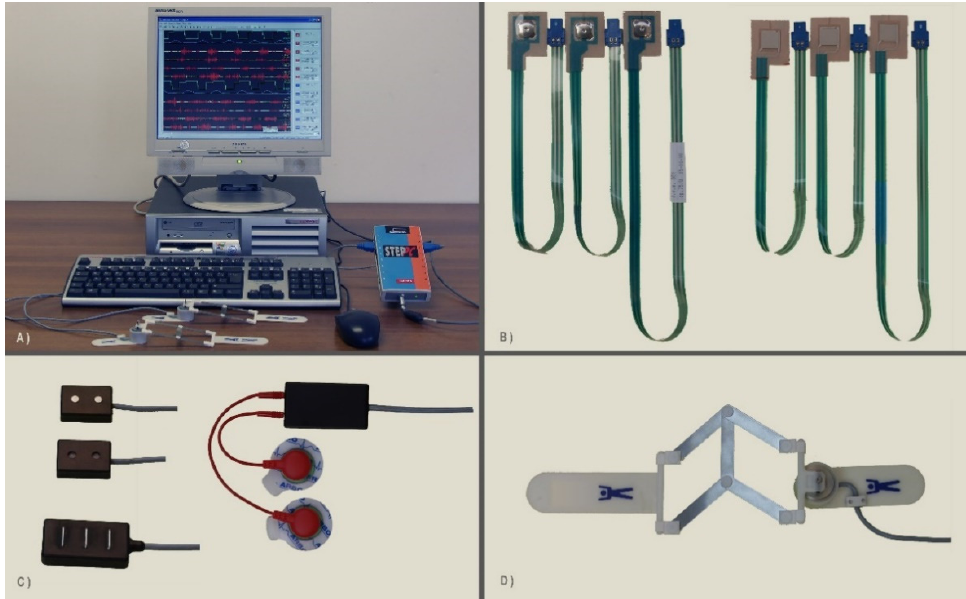
Figure 3. Details of the acquisition system: ( A ) the host computer, the patient unit, and two electrogoniometers; ( B ) two different kinds of foot-switches (on the left, a less sensitive set, for adults; on the right, a more sensitive set, for children); ( C ) different kinds of sEMG probes: two different versions of single differential probes (upper left); a three-bar double differential probe (lower left); a variable geometry probe (right); ( D ) a knee electrogoniometer.